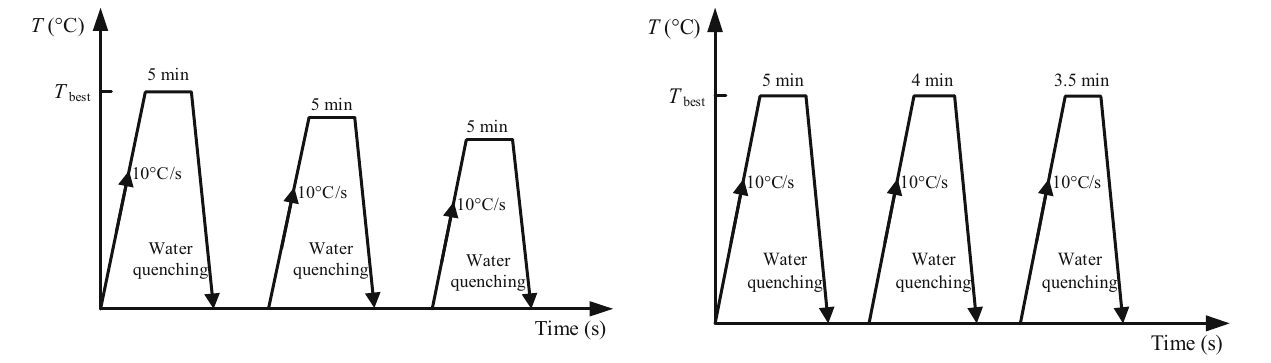
Figure 6: The diagram of the measured lath width.